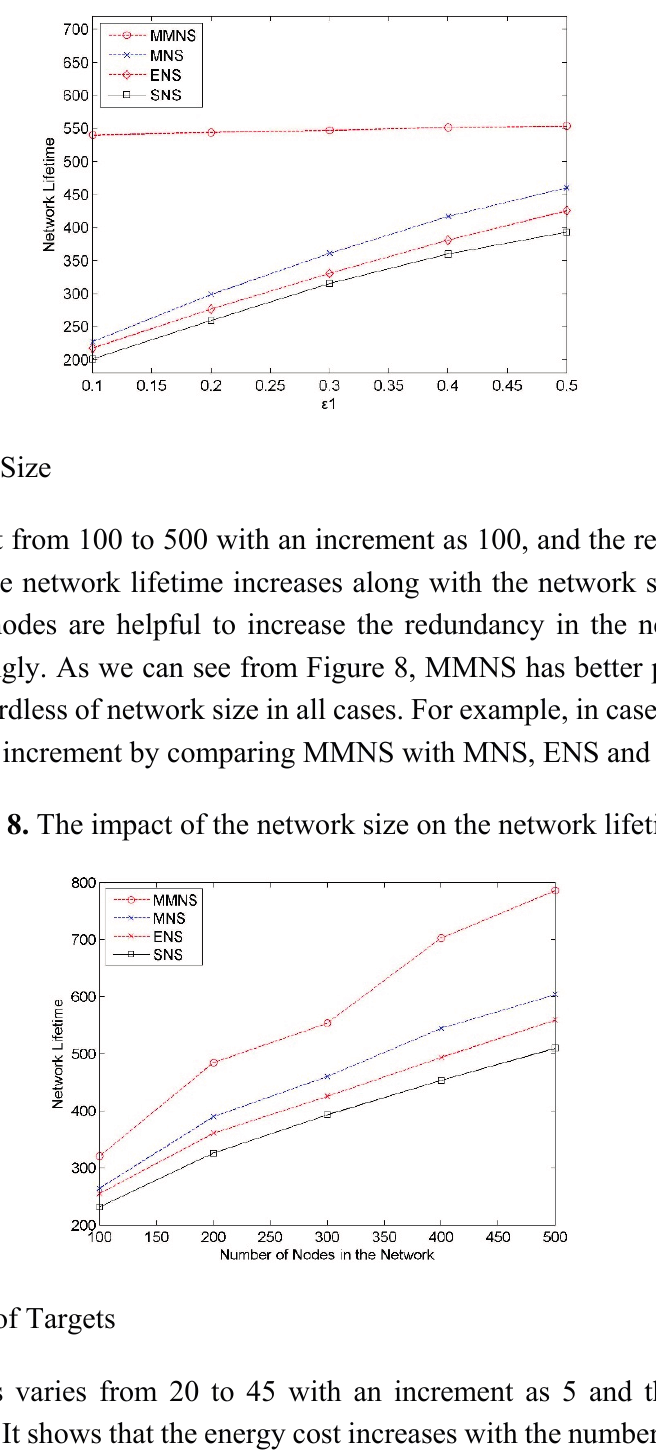
Figure 7. The impact of the error threshold on the network lifetime.